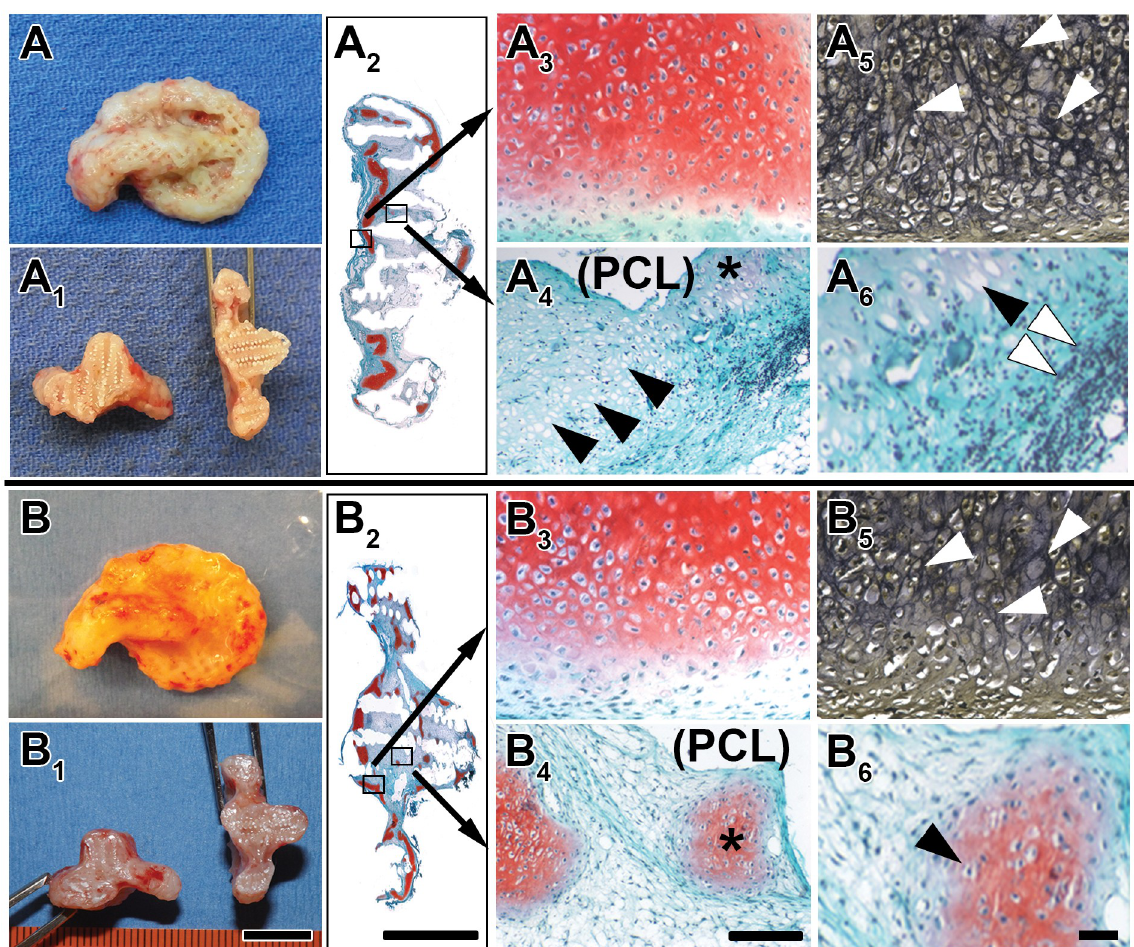
Fig 3. Representative histology of tissue-engineered auricle-shaped constructs comprised of human auricular chondrocytes seeded onto nanoPGA/PCL composite polymeric scaffolds with and without ethanol treatment and harvested following implantation for 10 weeks in nude mice. Gross morphology and histology of representative intact and bisected auricle-shaped constructs with their scaffolds either untreated (A-A6) or ethanol-treated (B-B6) prior to cell seeding and construct implantation in nude mice for 10 weeks. Glossy, white regenerated cartilage was more evident in ethanol-treated constructs (B and B1) when compared with their counterpart control constructs whose scaffolds were not subject to ethanol immersion (A and A1). Sections of typical constructs showed dissolution of core PCL as a result of specimen processing, leading to a checkered pattern of empty spaces (A2 and B2). Some aspects of the interior structure of these specimens remained partially intact and Saf-O and Verhoeff staining revealed the presence of proteoglycans and elastic fibers, respectively (A2 and B2). Saf-O staining was most evident at the periphery of sections and more abundant in constructs whose scaffolds were ethanol-treated (B2) compared to untreated (A2). Selected areas marked by small boxes (A2 and B2) were enlarged to show histological features more clearly. Proteoglycans (A3) and elastic fibers (A5, white arrowheads) were apparent in constructs comprised of untreated scaffolds and such specimens also consisted of fibrous tissue counterstained by fast green (A4, blue-green) near spaces created by PCL dissolution (A4, (PCL)), numerous empty chondrocyte lacunae (A4, black arrowheads), and small pockets of pale Saf-O staining (A4, asterisk). On greater enlargement (A6), empty lacunae (black arrowhead) and cellular infiltration (white arrowheads) were observed in sections. Constructs comprised of polymer scaffolds treated with ethanol maintained qualitatively more prominent proteoglycans stained with Saf-O (B3), many lacunae enclosing chondrocytes (B3) and distinctive elastic fibers revealed by Verhoeff staining (B5). Additionally, such specimens were found with fibrous tissue (B4, blue-green) neighboring PCL-devoid spaces (B4, (PCL)), areas of qualitatively greater Saf-O staining (B4, asterisk) compared to counterpart sections from constructs without ethanol exposure (A4), and, on enlargement, several chondrocytes within their lacunae (B6, black arrowhead). Cell infiltrates were typically absent from constructs whose scaffolds were ethanol-treated (B4 and B6). Scale bars = 1 cm (B1 [A, A1, and B at the same enlargement]), 1 cm (B2 [A2]), 200 μ m (B4 [A3-5, B3, and B5]), 50 μ m (B6